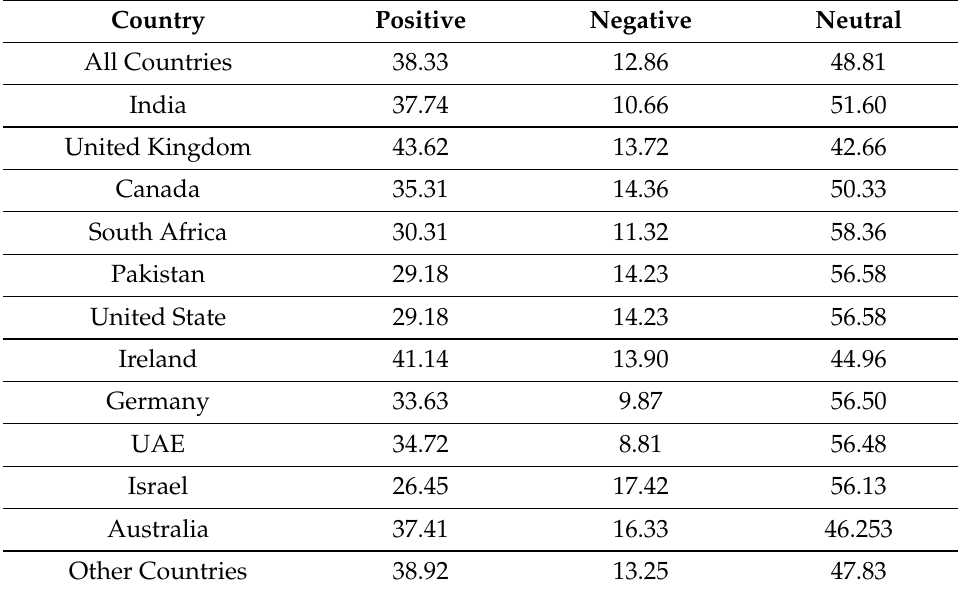
Figure 9. TextBlob sentiment score for tweets from different countries. Table 11. TextBlob sentiment statistics for each country and